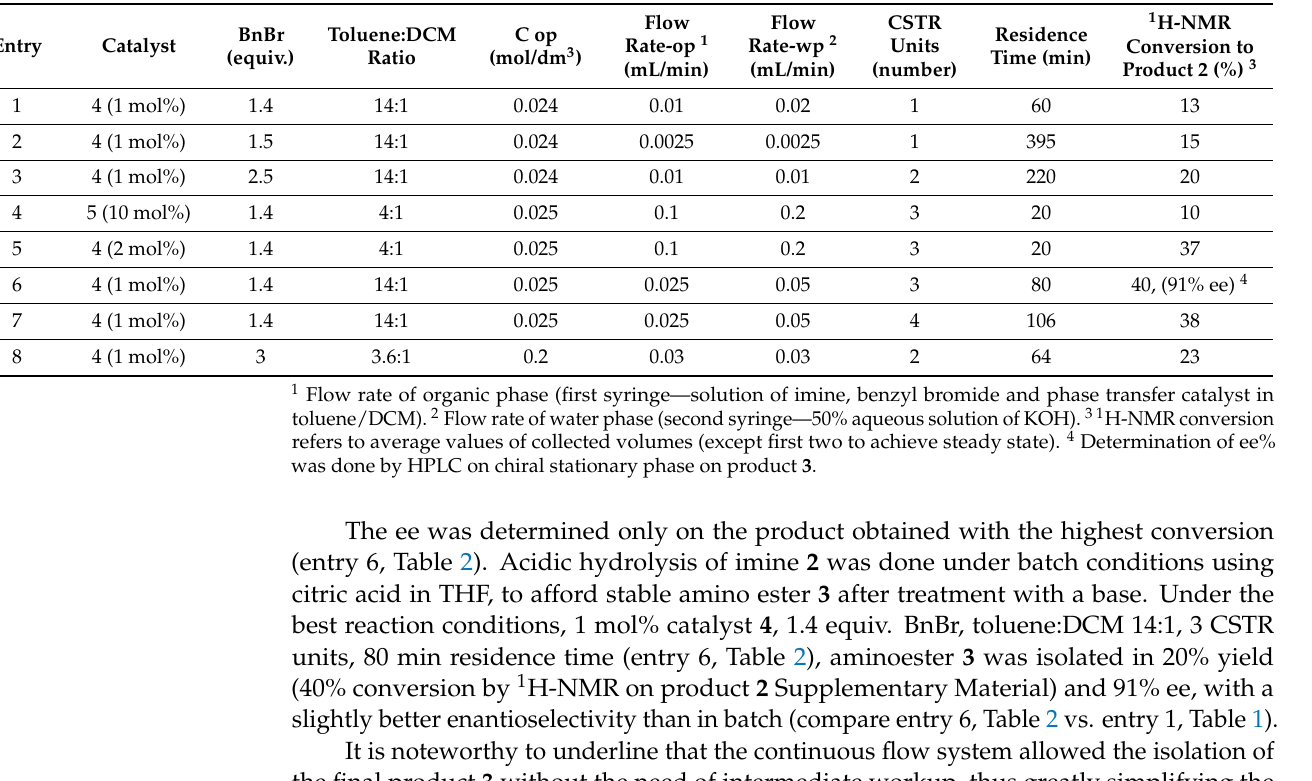
Table 2. Liquid-liquid asymmetric phase transfer benzylation of L-alanine imine 1 in flow in